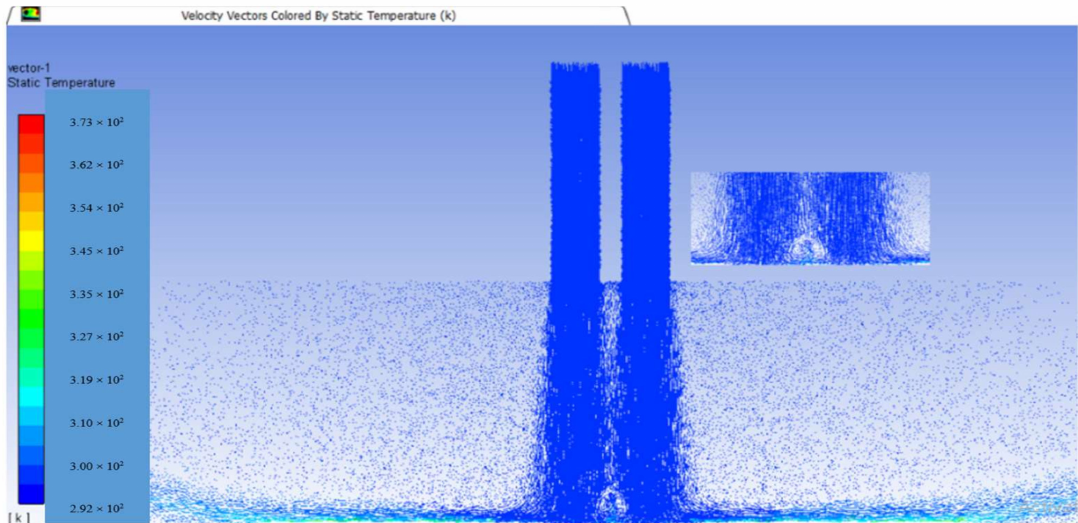
Figure 20. Velocity vectors colored by the static temperature of the twin impingement jet mechanism at the Nozzle-Nozzle spacing equal to 1 cm and the Nozzle-Plate distance equal to 11